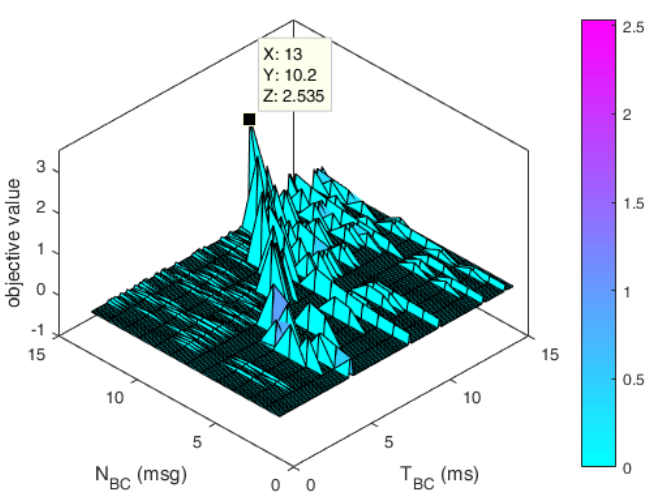
Figure 8. The objective values in the search space at the final iteration of the FRMCO.